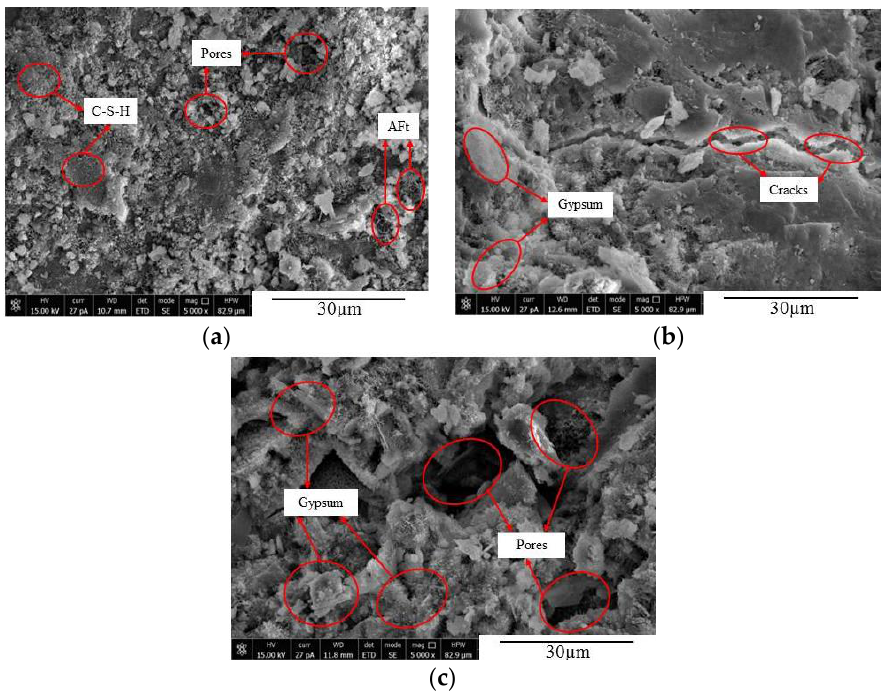
Figure 12. Microcrack expansion of FA0 concrete at different corrosion times. ( a ) FA0-D0; ( b ) FA0-D90; and ( c ) FA0-D150.